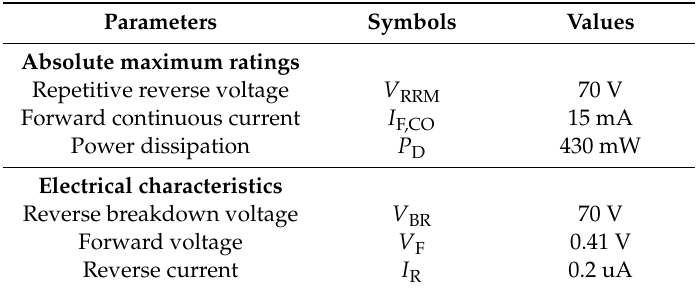
Table 6. 1N5711 Schottky diode (D0) specifications.